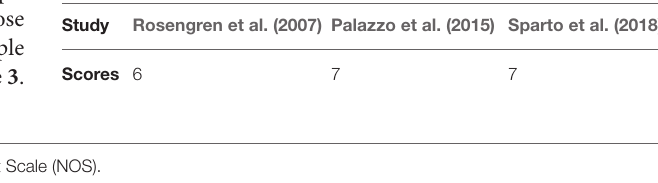
TABLE 2 | Quality assessment of cross-sectional studies.